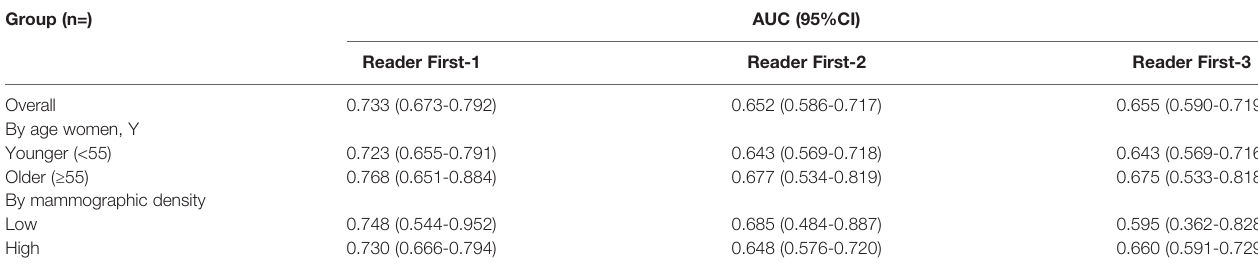
TABLE 2 | Area under the receiver operating characteristic curve for the 3 fi rst readers. Group (n=)